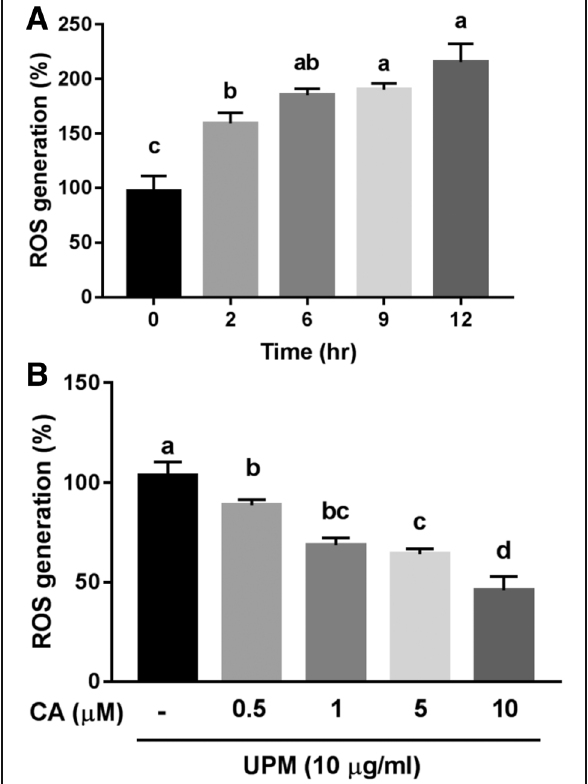
Fig. 2 Inhibition by CA of UPM-induced intracellular ROS generation. Effect of exposure to UPM (10 μ g/mL) for 0 to 12 h on ( a ) NCI-H441 cells. Effect of exposure to UPM (10 μ g/mL) for 12 h after pretreatment with CA (0.5, 1, 5, and 10 μ M) for 24 h on NCI-H441 cells ( b ). Data are means ± SD of three experiments with triplicate samples and different letters indicate significant differences at p < 0.05 by Tukey ’ s